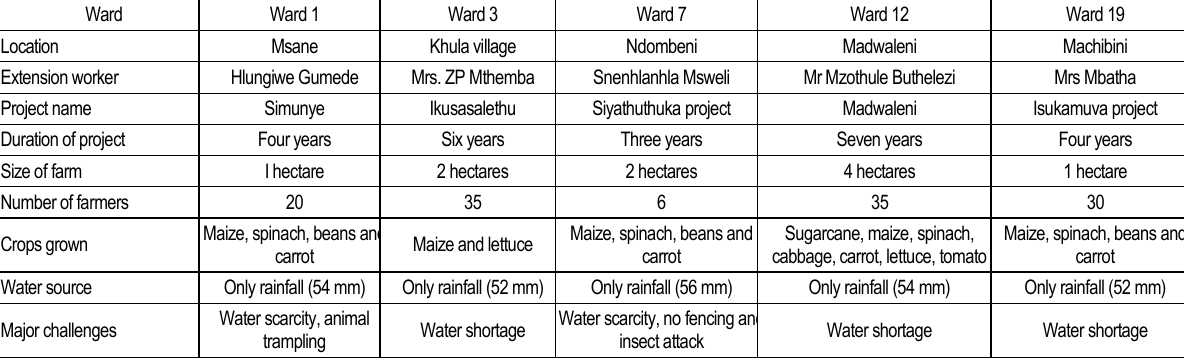
Table 1. On-going subsistence farming projects in Machibini and environ (Mtubatuba Municipality)